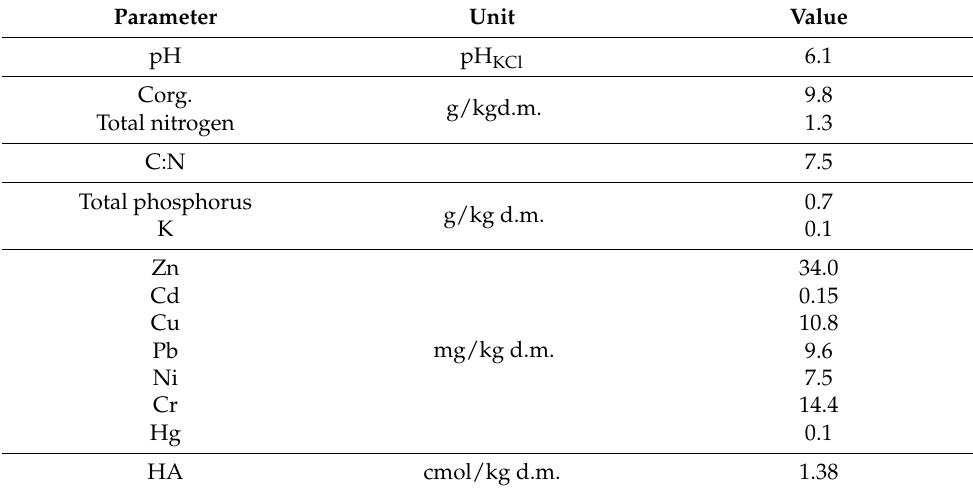
Table 1. Chemical characteristics of the soil used in the experiment. Parameter Unit Value pH Corg.